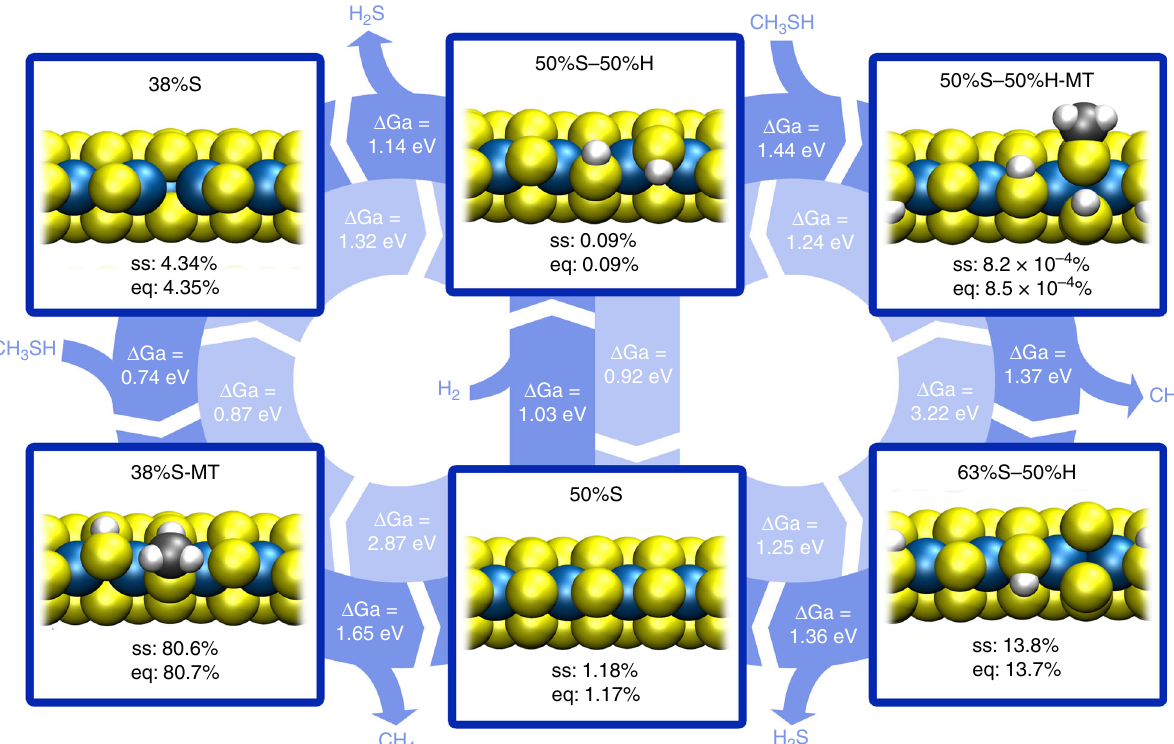
Fig. 5 Reaction network for CH 3 SH desulfurization on MoS 2 /Au(111). The activation free energy barriers ( Δ G a ) indicated in the arrows were calculated based on the experimental conditions (P CH3SH = 0.1 bar, P H2S = ~0.001 bar, P H2 = 0.9 bar, 250 °C). The abundances of intermediates in steady state conditions and in an equilibrium where the C – S bond breaking step is disabled are designated by ss and eq, respectively. The steady state concentrations were derived using transition state theory and rate equation modeling (see Methods section). MT corresponds to methane